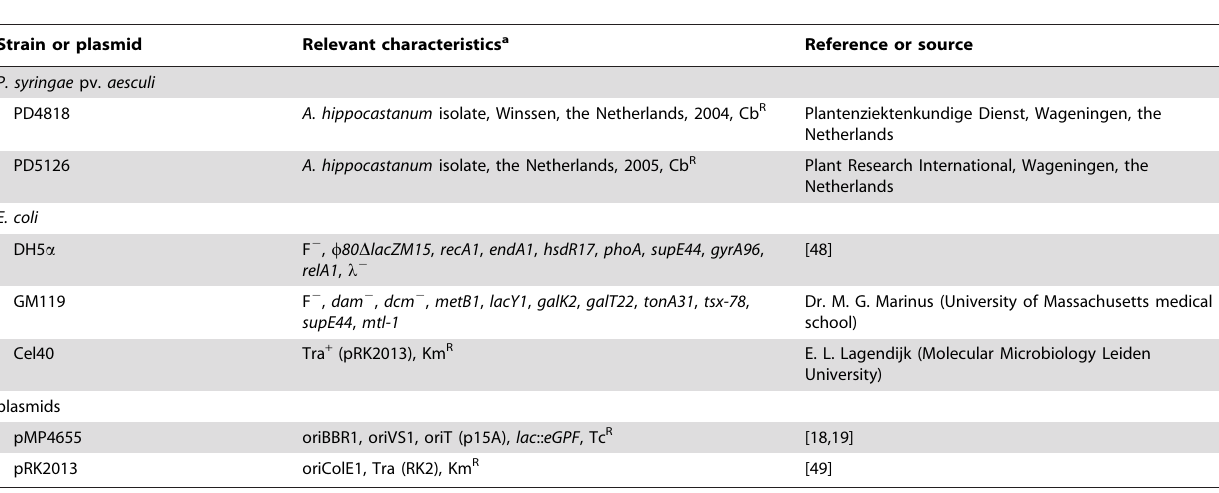
Table 1. Bacterial strains and plasmids used in this